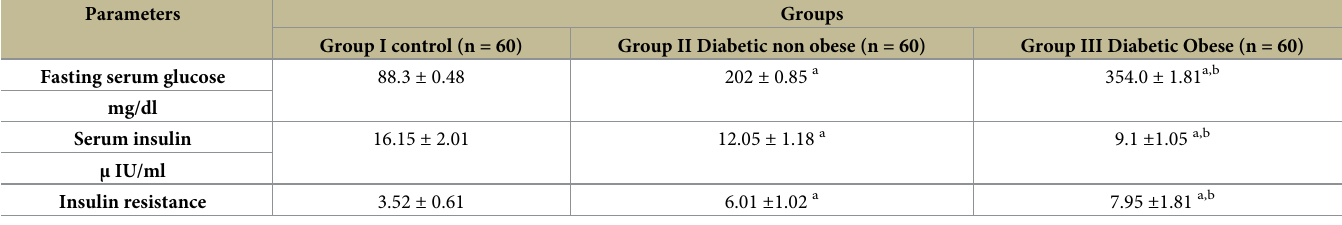
Table 1. Fasting blood glucose, serum insulin and insulin resistance in the different studied groups represented as mean ± SEM.